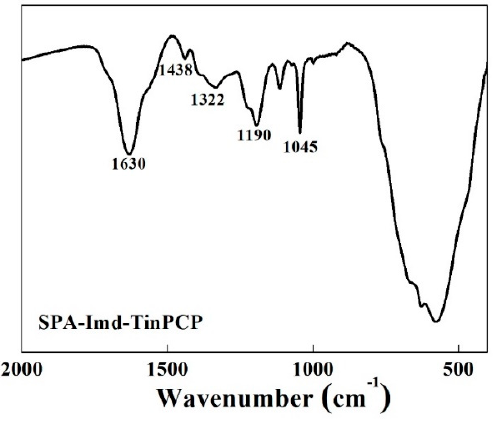
Figure 5. FTIR spectrum of SPA-Imd-TinPCP.